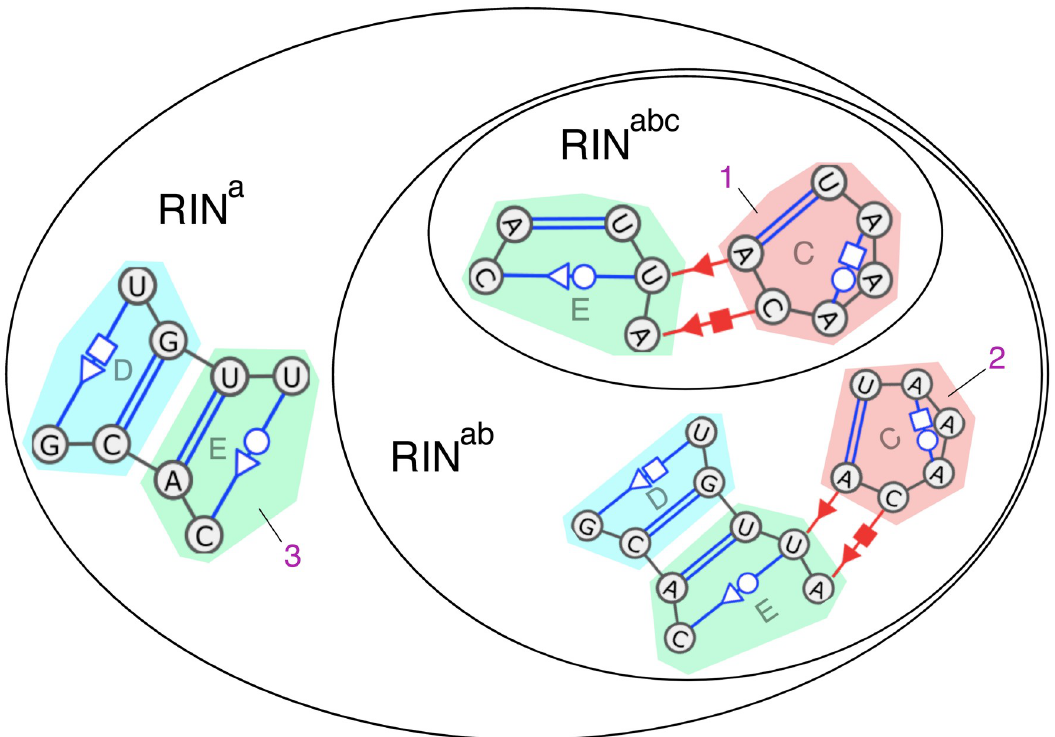
Fig 7. Examples of structures to illustrate the three RIN classes. Those three graphs displayed inside a Venn diagram are subgraphs of Fig 1 with the same SSEs annotations (SSEs D,C and E figured with colored areas). Graph #1 is valid for all three classes. Graph #2 spans over 3 SSEs and so cannot be a valid RIN abc . Graph #3 does not contain long-range interactions and thus is only valid for class RIN a